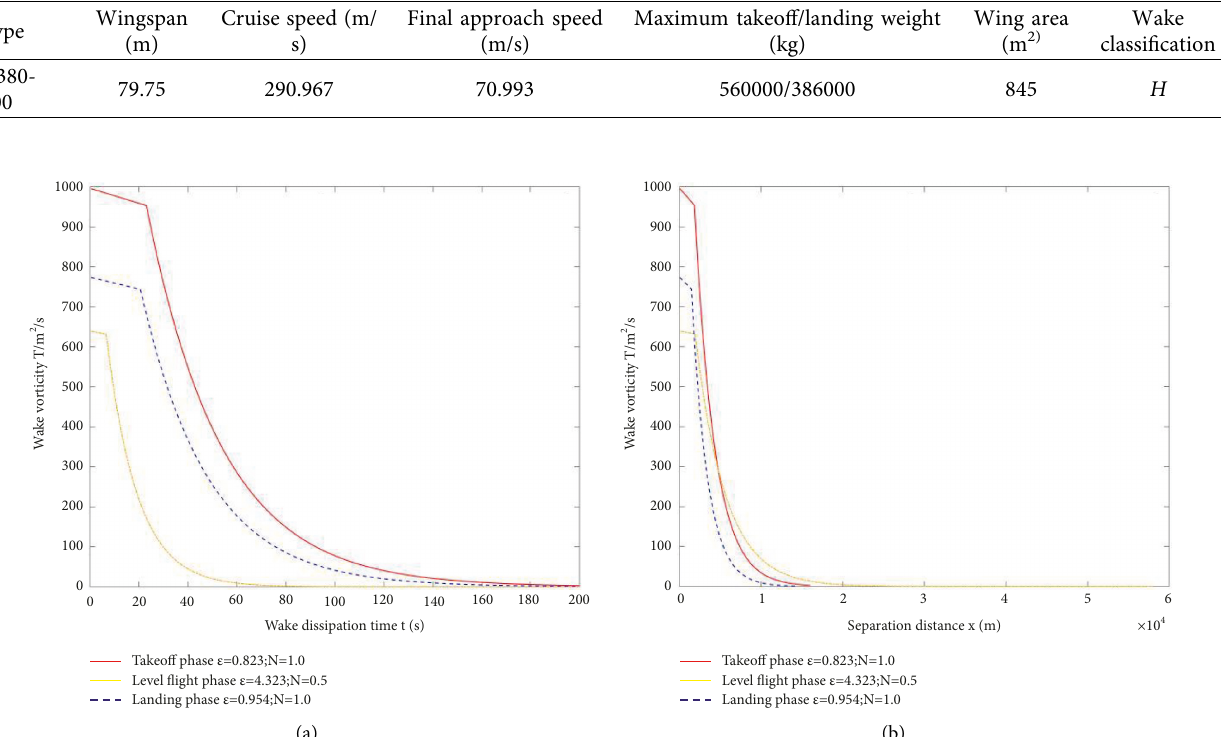
Table 1: A380 type parameters.